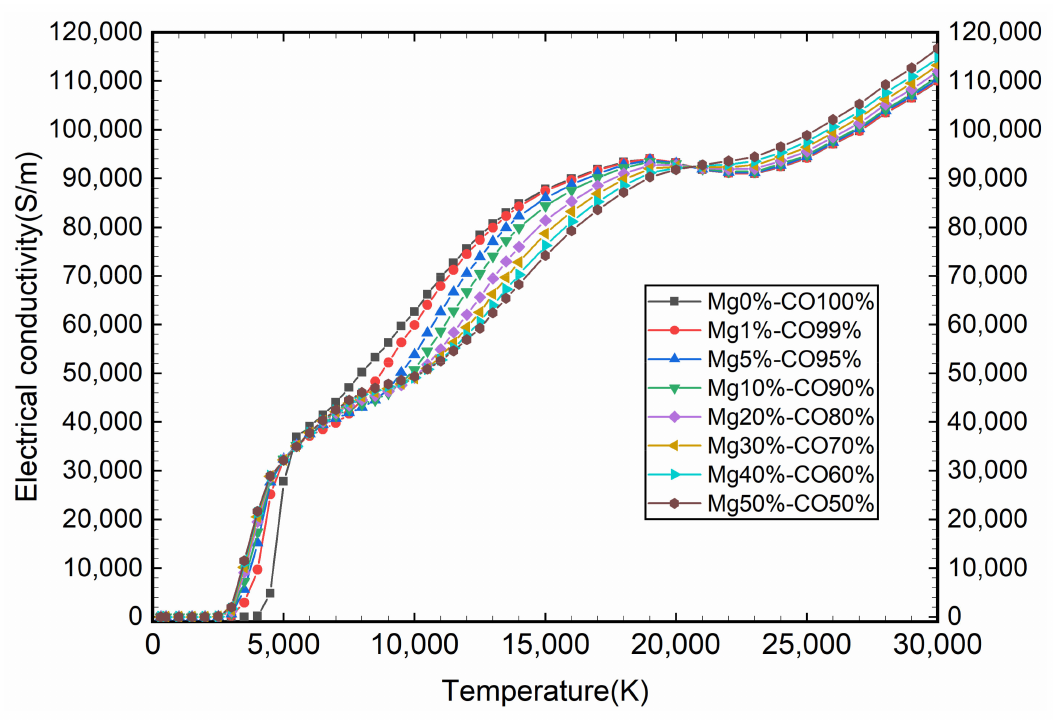
Figure 13. The curves of electrical conductivity for different proportion of Mg-CO mixtures plasma at a temperature of 300–30,000 K and 0.1 Mpa.